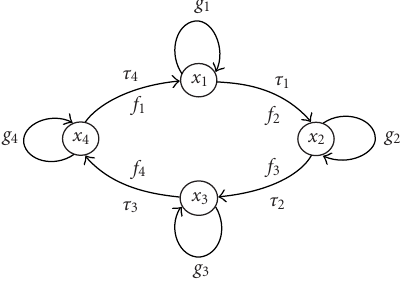
Figure 1.2. A four-neuron ring with delays and